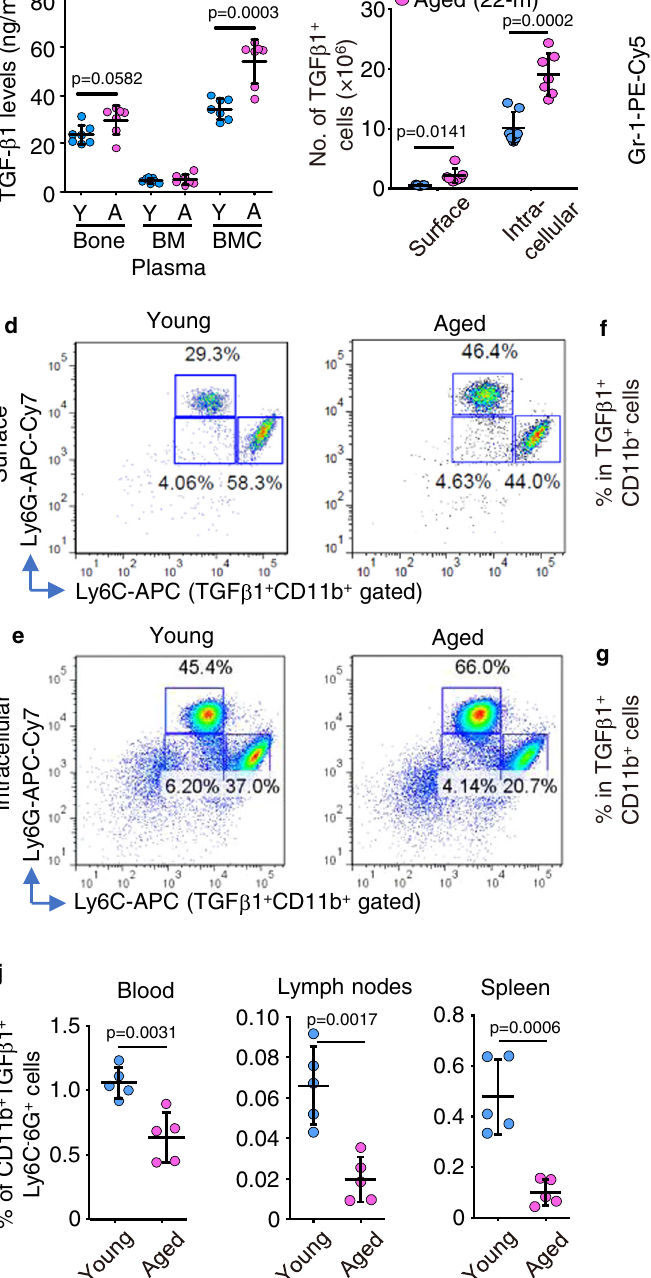
TGF β 1surfaceandintracellularexpressioninBMfrom4-and22-mon-oldC57mice, and frequencies ( f , g ) and numbers ( h , i ) of monocytic (Ly6C hi 6G - ), granulocytic (Ly6C - 6G + ) and intermediate-stage (Ly6C lo 6G - ) cells in TGF β 1 + CD11b + myeloid cells inBM.Mean±SD( n =7biologicallyindependentmalemice/group). j Frequenciesof TGF β 1 + CD11b + Ly6C - 6G + cells in peripheral blood, mesenteric lymph nodes, and spleen.Mean±SD( n =5biologicallyindependentmalemice/group). k H&E-stained Ly6C + and Ly6G + subpopulations from TGF β 1 + CD11b + myeloid cellsfollowing FACS and cyto-spinning. Bar=10 μ m. Analyses: Student ’ s two-sided unpaired t test. Source data are provided as a Source data fi